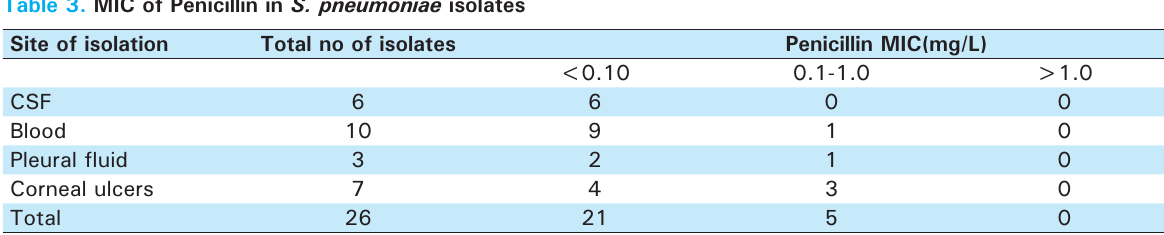
Table 3. MIC of Penicillin in S. pneumoniae isolates Site of